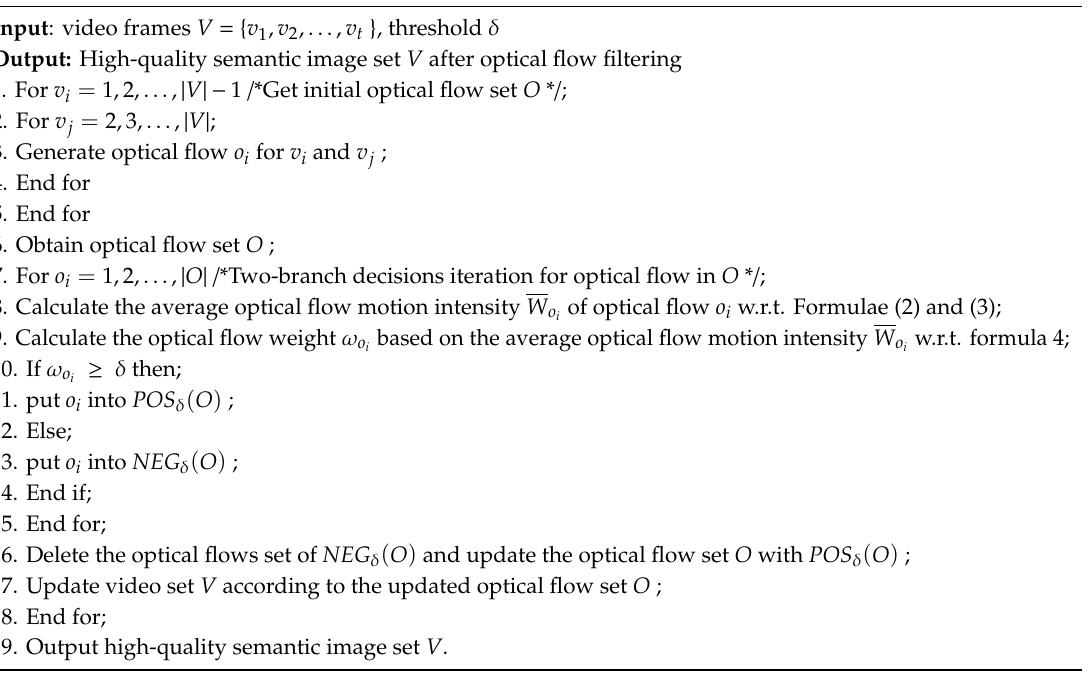
Algorithm 1 Optical Flows Filtering Algorithm Based on Two-Branch Decisions